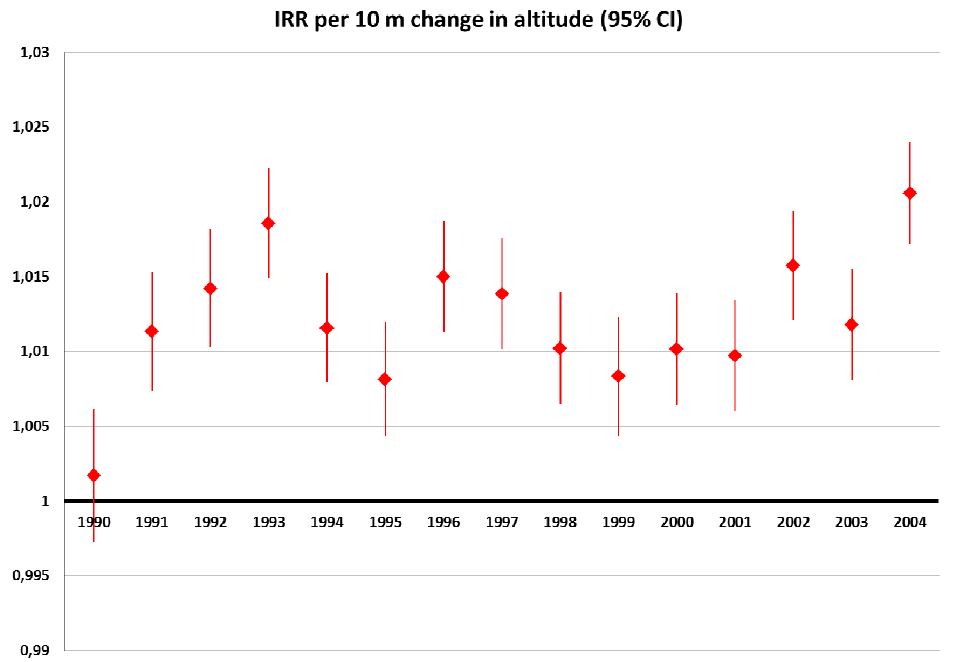
Figure 1. Annual melanoma incidence risk ratios (IRR) per 10 m increase in altitude: Age-adjusted data, controlled for urban versus rural districts, and offset by district population (1991